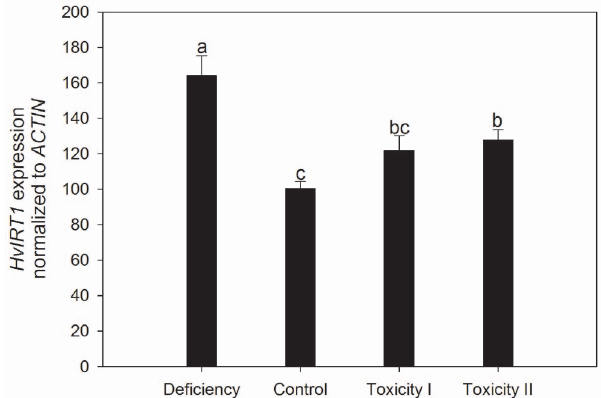
Fig. 7. Quantitative expression analysis of IRT1 in root tissue of barley plants grown with insufficient, control or two increasing Mn toxicity levels. Data are normalized with respect to the expression of the reference gene ACTIN . Furthermore the relative change in IRT1 expression is indexed to barley plants grown under control conditions. Data represent means ¡ SE (n 5 3). Values with the same letter between treatments are not significantly different (P .